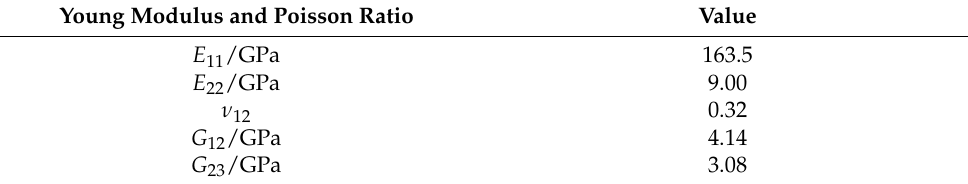
Table 1. Basic material parameters.